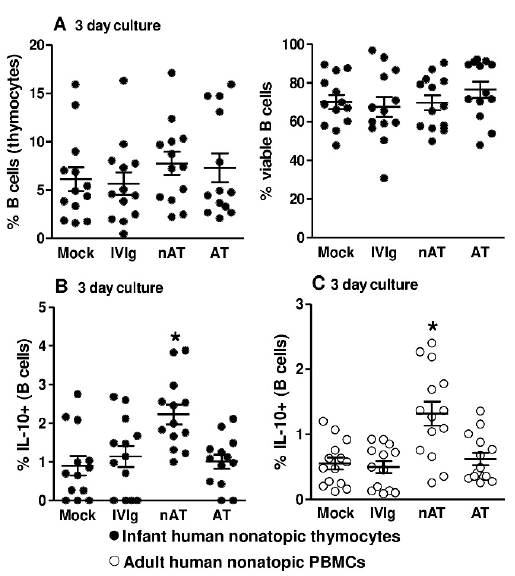
Figure 6. Effects of purified IgG on nonatopic infant intrathymic or nonatopic adult peripheral B cells. Purified IgG from atopic or nonatopic adults was pooled. Thymocytes from nonatopic infants younger than 7 d.o. ( n = 13) were cultured in the absence (mock) or presence of 100 µ g / mL commercial IgG (IVIg) or IgG purified from nonatopic (nAT) or atopic (AT) individuals. The frequency and viability of cultured B cells were evaluated after 3 days of culture ( A ) Spontaneous IL-10 production by thymic B cells was also evaluated ( B ) Freshly isolated PBMCs from nonatopic adults ( n = 13) were cultured under the same conditions and evaluated after 3 days of culture. Spontaneous IL-10 production by peripheral B cells was also evaluated ( C ) Data are presented as each individual value, mean ± SEM. * p ≤ 0.05 compared with the control groups (mock and IVIg).